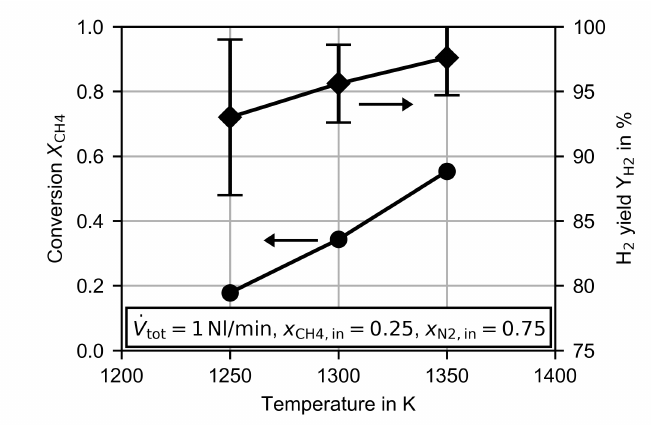
Figure 6. Methane conversion and hydrogen yield dependent on of the temperature at a constant flow rate of